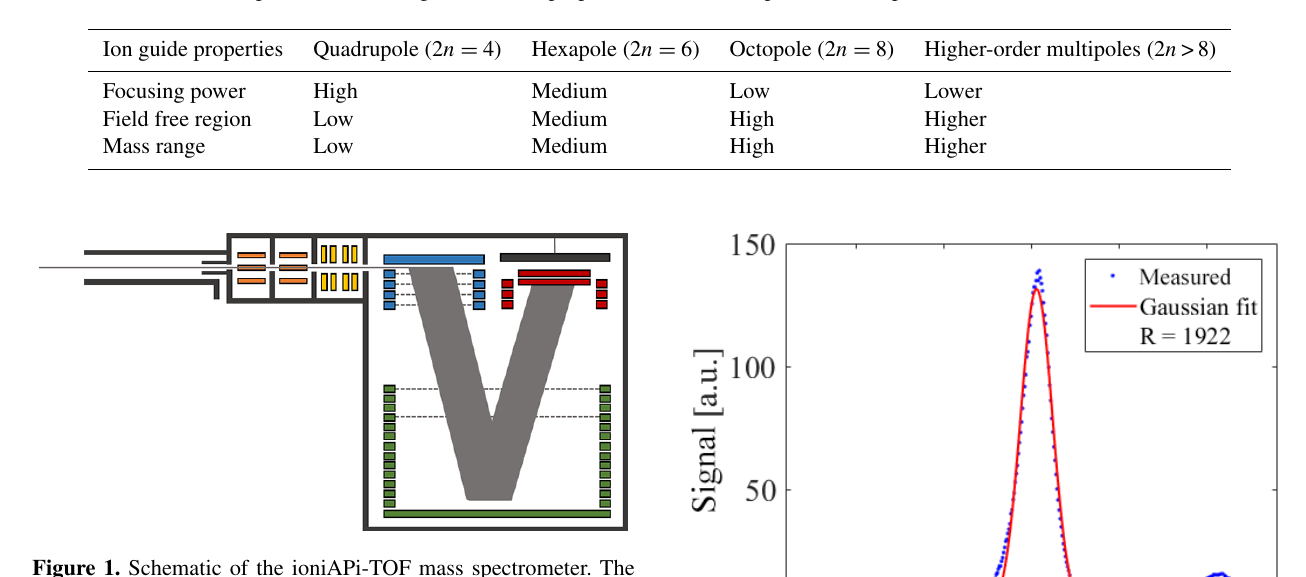
Table 1. Qualitative comparison of the ion guide transfer properties of ideal multipoles with 2 n poles (Gerlich, 1992).